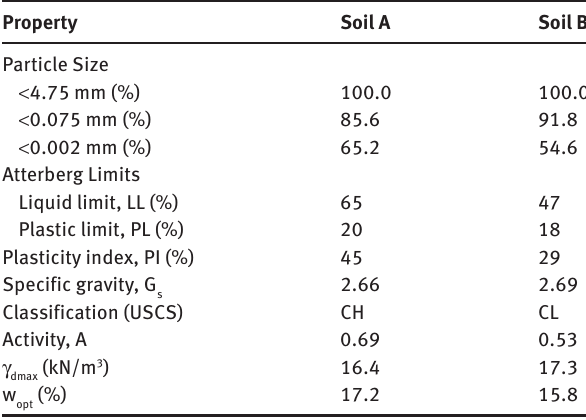
Table 1: Geotechnical properties of soils used in the study.